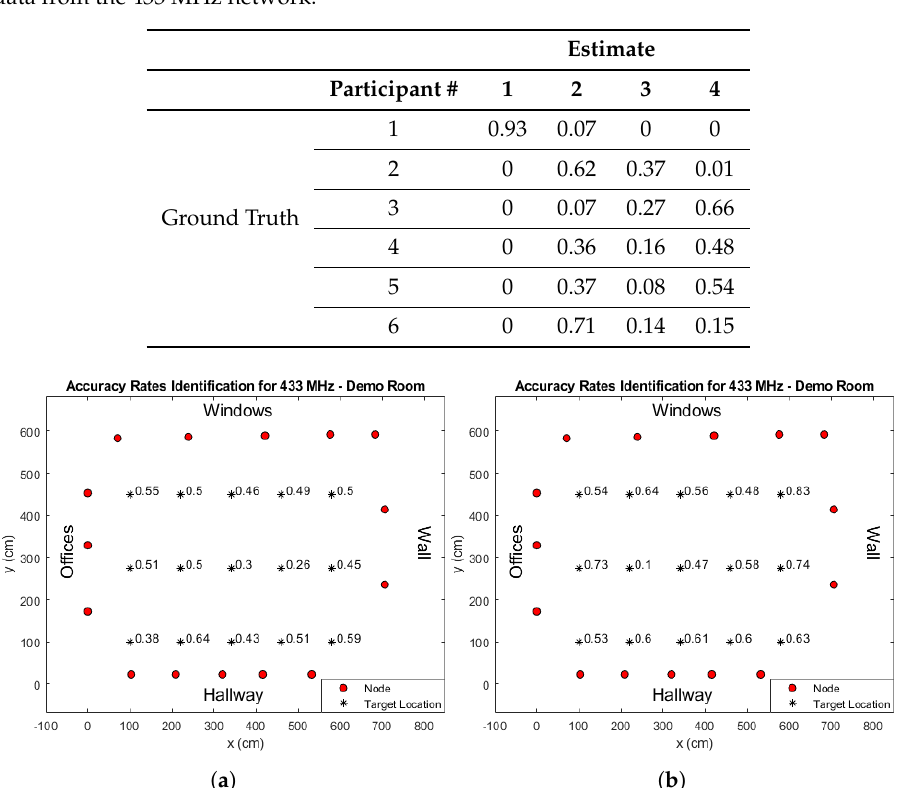
Table 11. Confusion matrix for identification based on a naive Bayesian classifier approach applied to RSS data from the 433 MHz network.